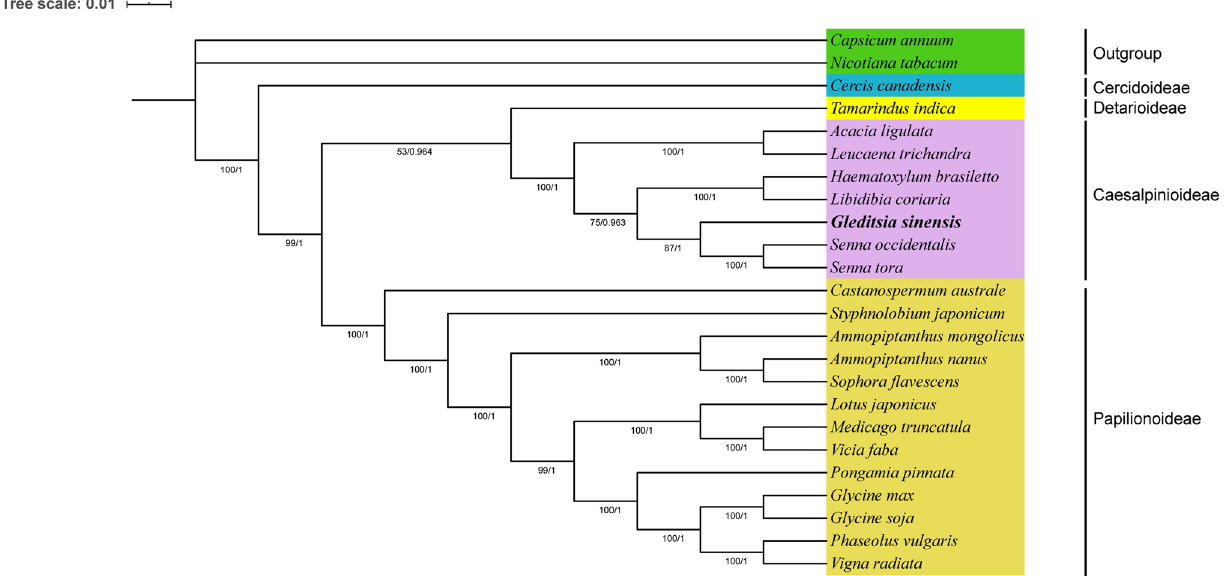
Figure 6. Maximum likelihood phylogenies of G. sinensis within Fabaceae. Relationships were inferred using 17 conserved PCGs of 24 plant mt genomes. Numbers on each node are bootstrap support values and posterior probabilities. The scale indicates the number of nucleotide substitutions per